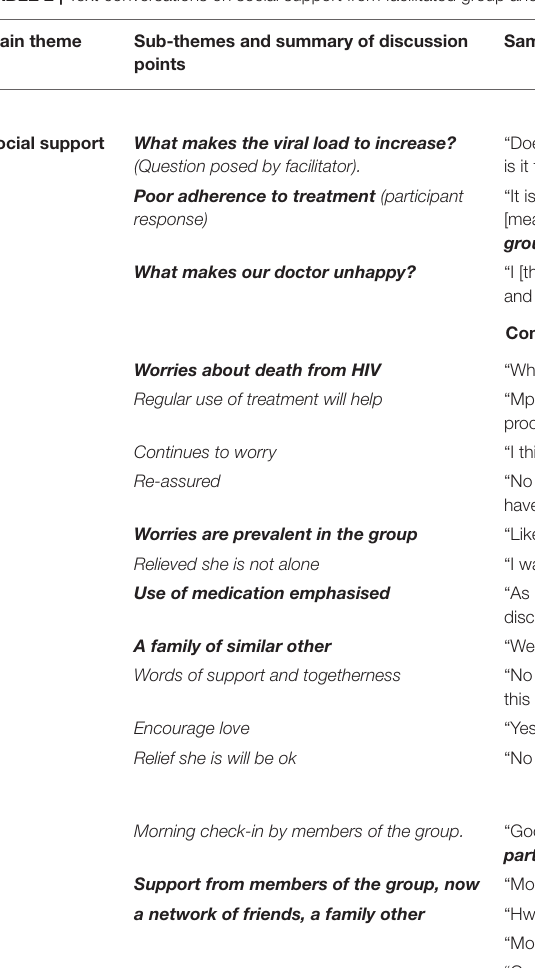
TABLE 2 | Text conversations on social support from facilitated group and one-on-one text